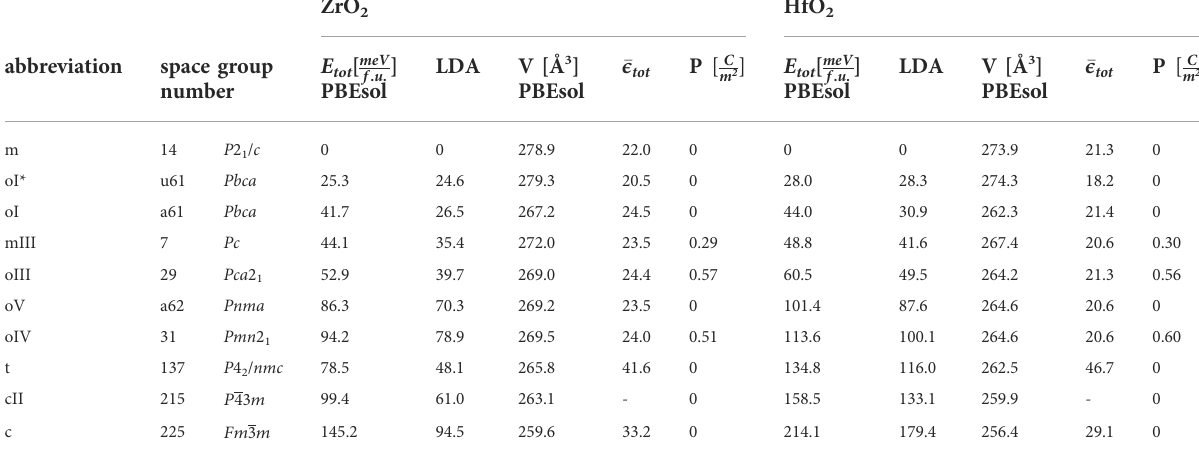
TABLE 1 DFT calculated total energies of low-energy crystal structures relative to the monoclinic phase, calculated with PBEsol and LDA, crystal volume per 24-atomic cell, averaged (electronic plus ionic) dielectric constant, and remanent polarization. ZrO 2 HfO 2 abbreviation